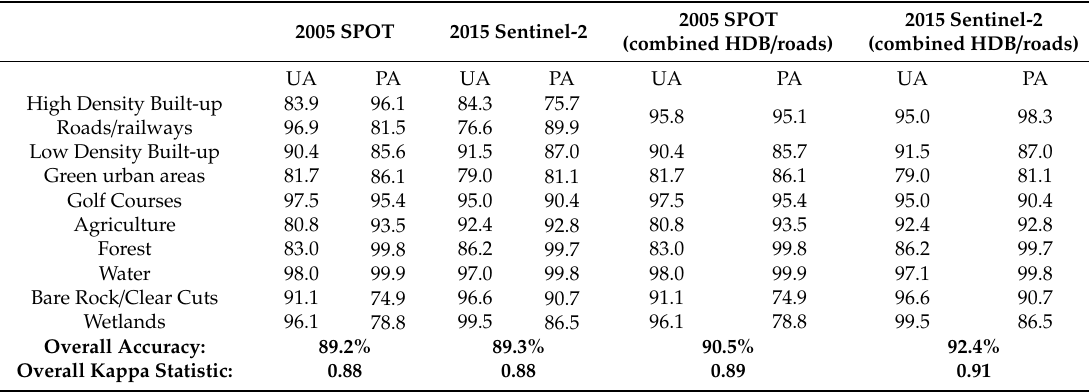
Table 4. Class and overall accuracy scores for the 2005 and 2015 classifications. The two right-hand columns present accuracies for updated classifications with combined high-density residential / commercial built-up areas (HDB)-Roads / railway classes. 2005 SPOT 2015